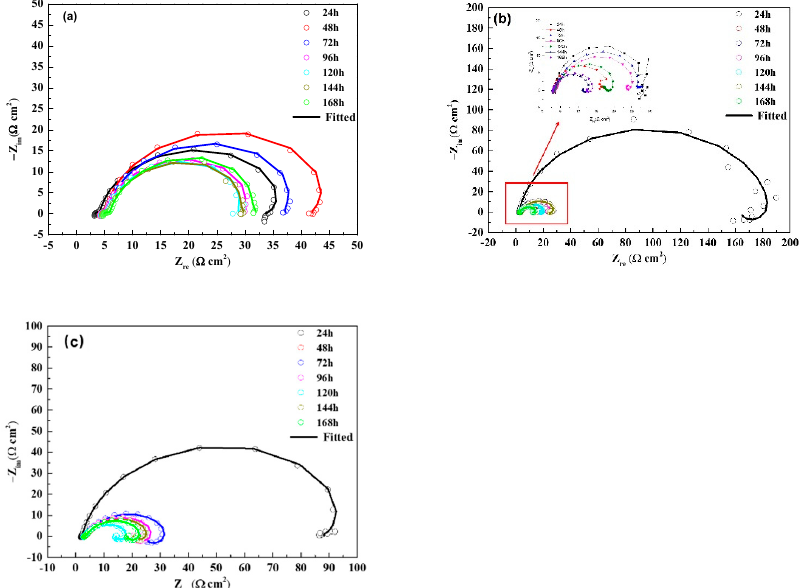
Figure 7. Nyquist plots of EIS results after the 168 h flow loop tests at ( a ) 20 °C, ( b ) 50 °C, and ( c ) 60 °C.